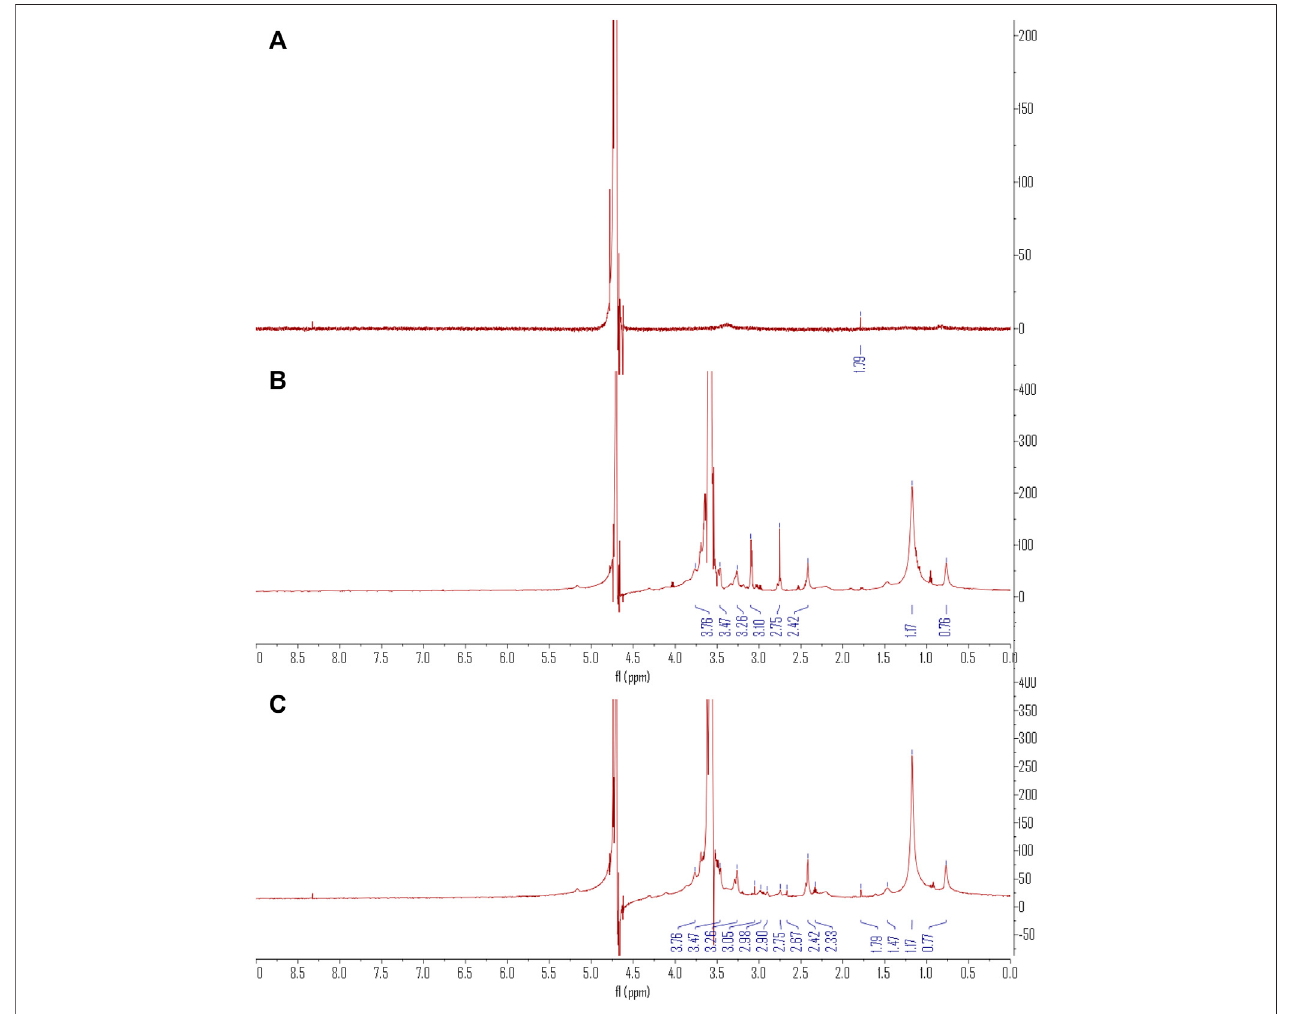
FIGURE 2 | The 1 H NMR spectra of C60(OH) 22 (A) , DSPE-PEG-NH 2 (B) , and DSPE-PEG-C60 (C) .